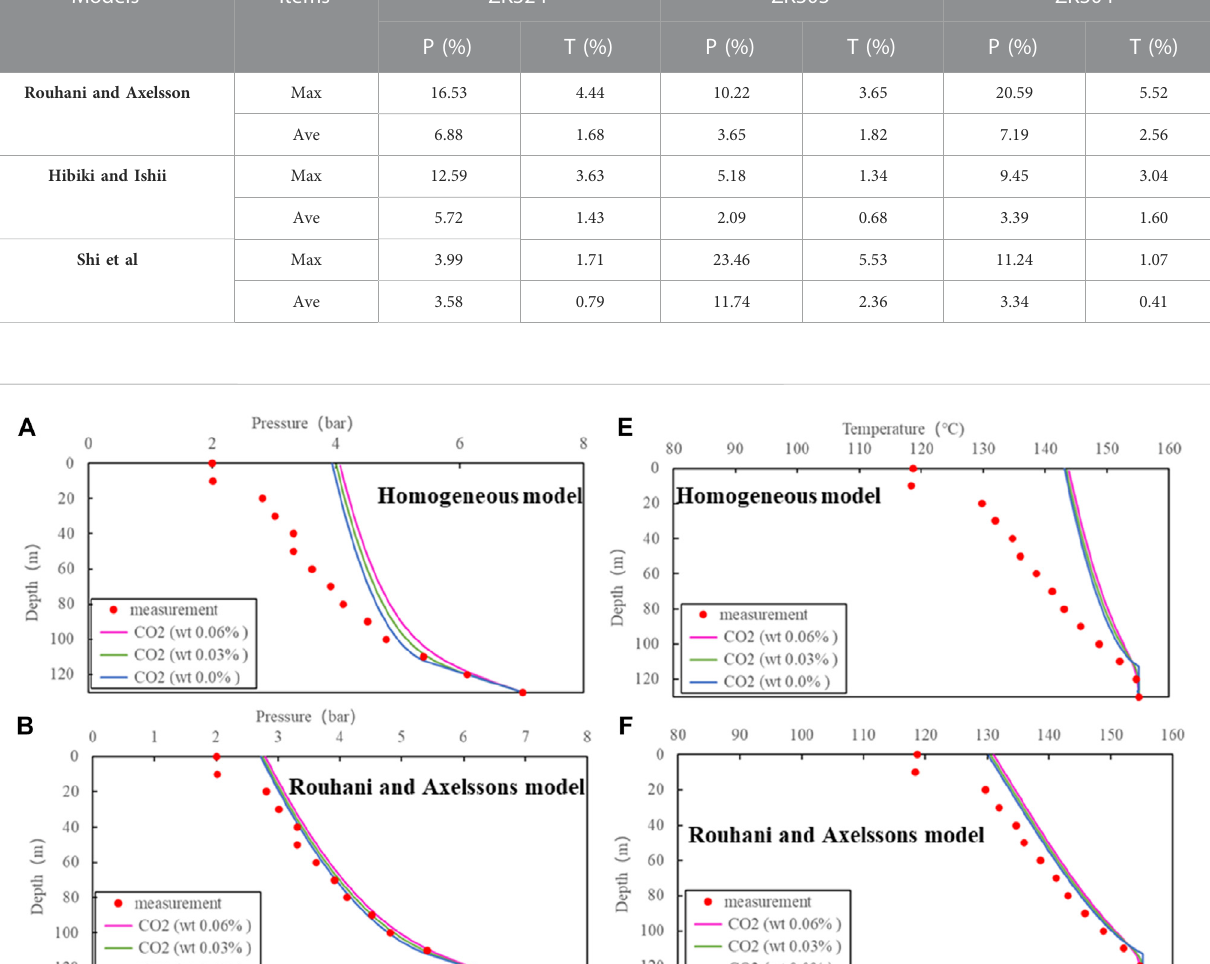
TABLE 3 Errors between the calculations and measurements for different Drift fl ux models. Models